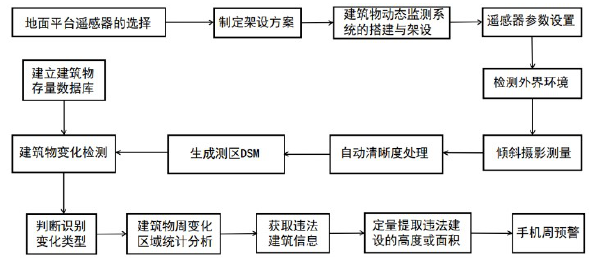
Figure 1. Technical flow chart of the dynamic monitoring method for illegal buildings using large-scale urban terrain to sense big data.